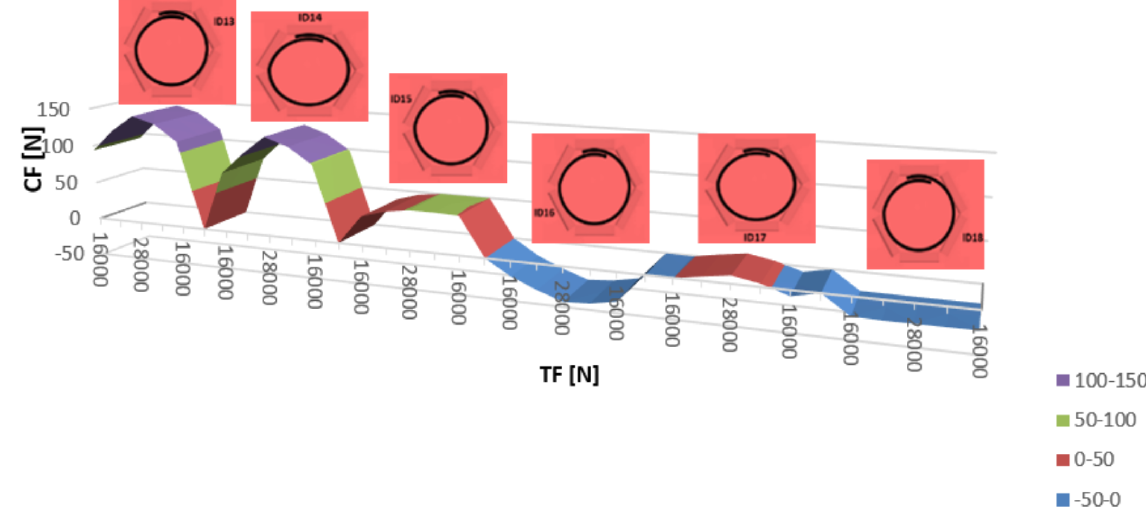
Figure 10: The course of CF for hexagonal idler housing No.3